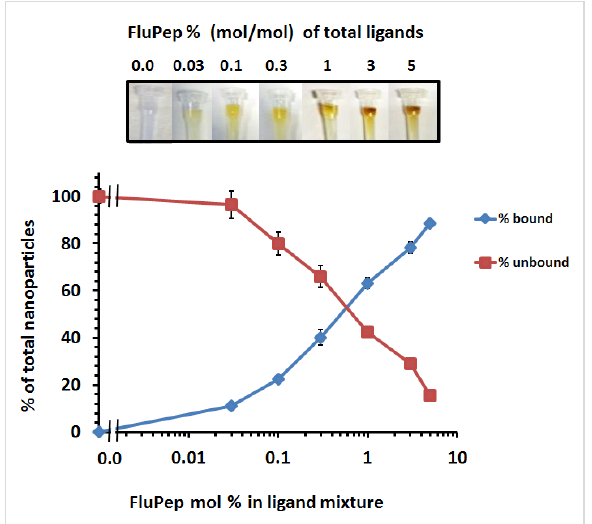
Figure 6: Purification of FluPep ligand-functionalised silver nanoparti- cles by CM-Sepharose cation-exchange chromatography. Silver nano- particles functionalised with different molar fractions of FluPep ligand were subjected to chromatography on CM-Sepharose. Top: images of columns after loading and washing with PBS. Bottom: quantification of unbound (flow-through and PBS wash fractions) and bound (eluted with 2 M NaCl) fractions as a percentage of the total nanoparticles applied to the column. Results are the mean ± SD ( n = 3).